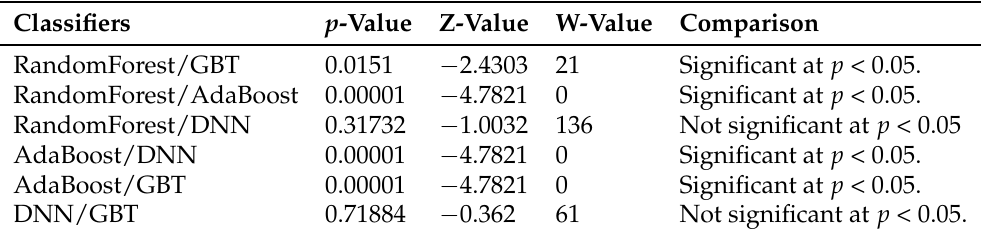
Table 13. Statistical analysis of the classifiers by accuracy of the model based on paired Wilcoxon test with p -value